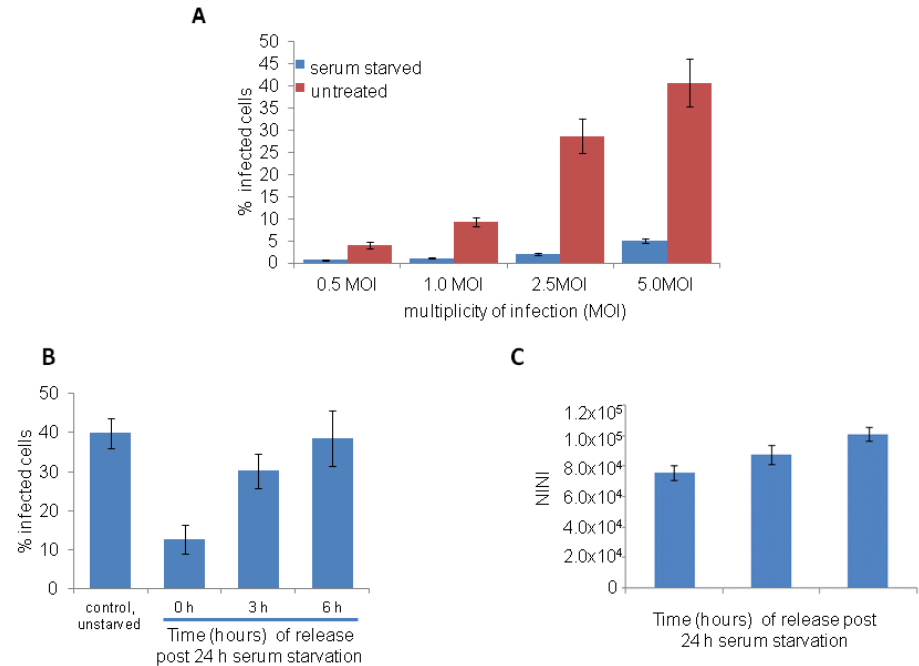
analyzed. A time-dependent increase in the EBOV infection ( B ) and increase in